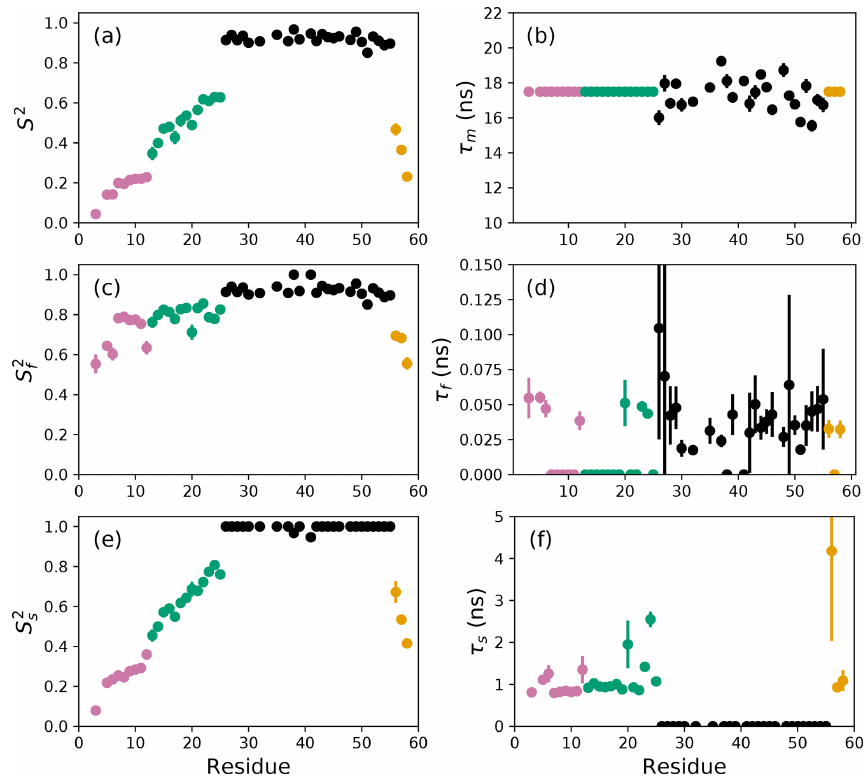
Figure 3. Model-free parameters from conventional model selection using AIC C and bootstrap resampling to determine parameter uncer- tainties. Values of S 2 , τ m , S 2 , τ f , S 2 s , and τ s are plotted vs. residue number. Parameter values are identical as in Fig. 2, but the uncertainty f estimates differ. Regions of the protein are colored as basic region 1 (residues 3–12) (reddish-purple), basic region 2 (residues 13–25) (green), coiled-coil (residues 26–55) (black), and disordered C-terminus (residues 56–58) (orange) (Gill et al., 2016). Table 3. Model-free parameters for selected residues.